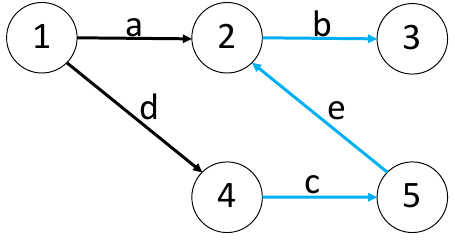
Figure 4. Directed graph with a path from vertex 4 to vertex 3